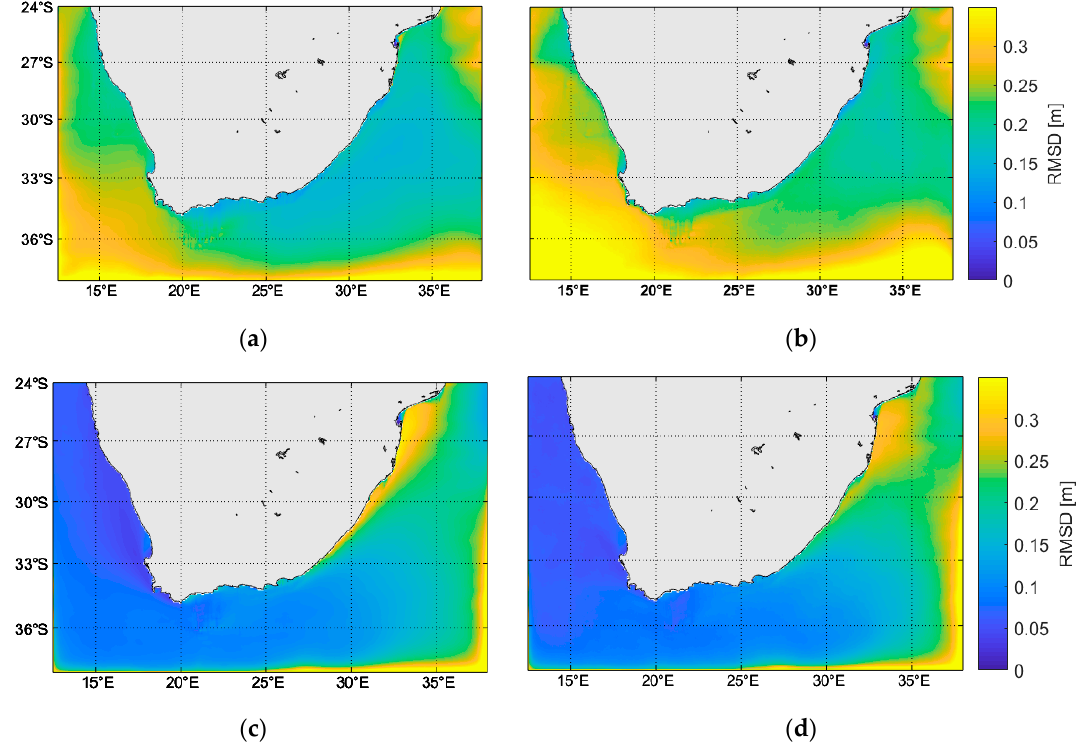
Figure 7. Spatial RMSD maps for June 2017. Here all the reconstructed boundary condition scenarios are compared with the fully spectral output boundary conditions. The particular scenarios are ( a ) M1, ( b ) M2, ( c ) M5, and ( d ) M6.